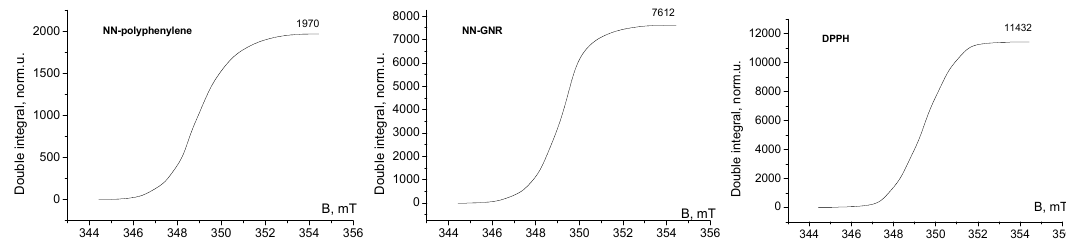
Figure 4. Spectra and their first and second integrals for the three “organic” samples. The numbers given in the panels with second integrals are proportional to the absolute numbers of spins in the samples.